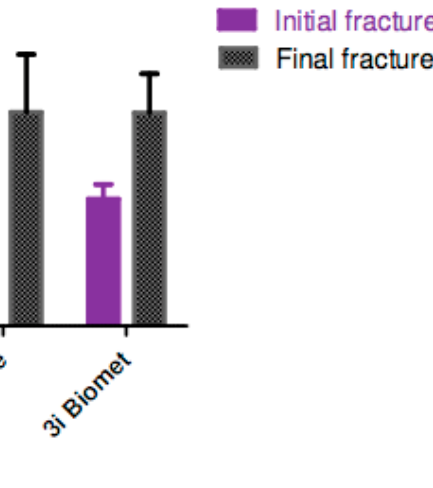
Figure 4. Initial and final fracture amplitude (dB) of the assembly specimens.